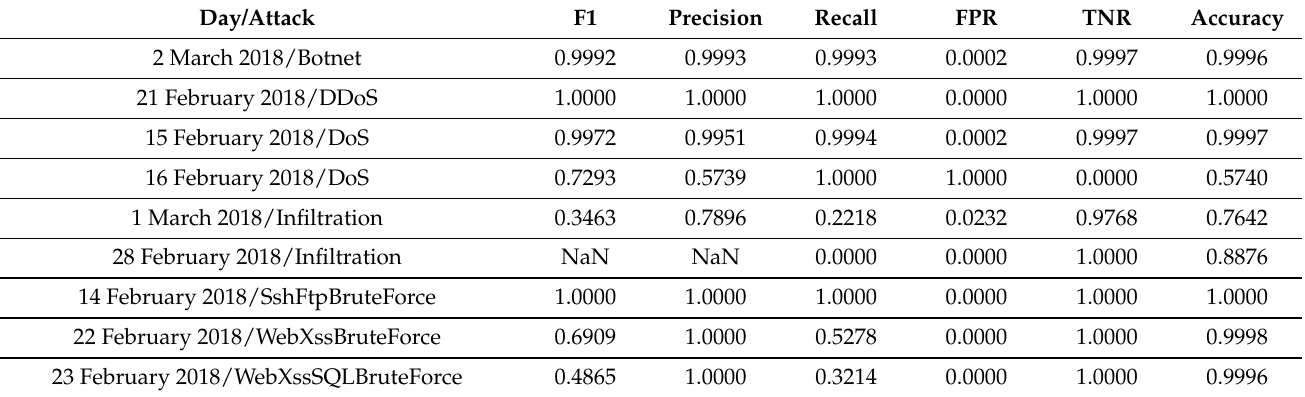
Table 8. Results obtained with a training CNN and